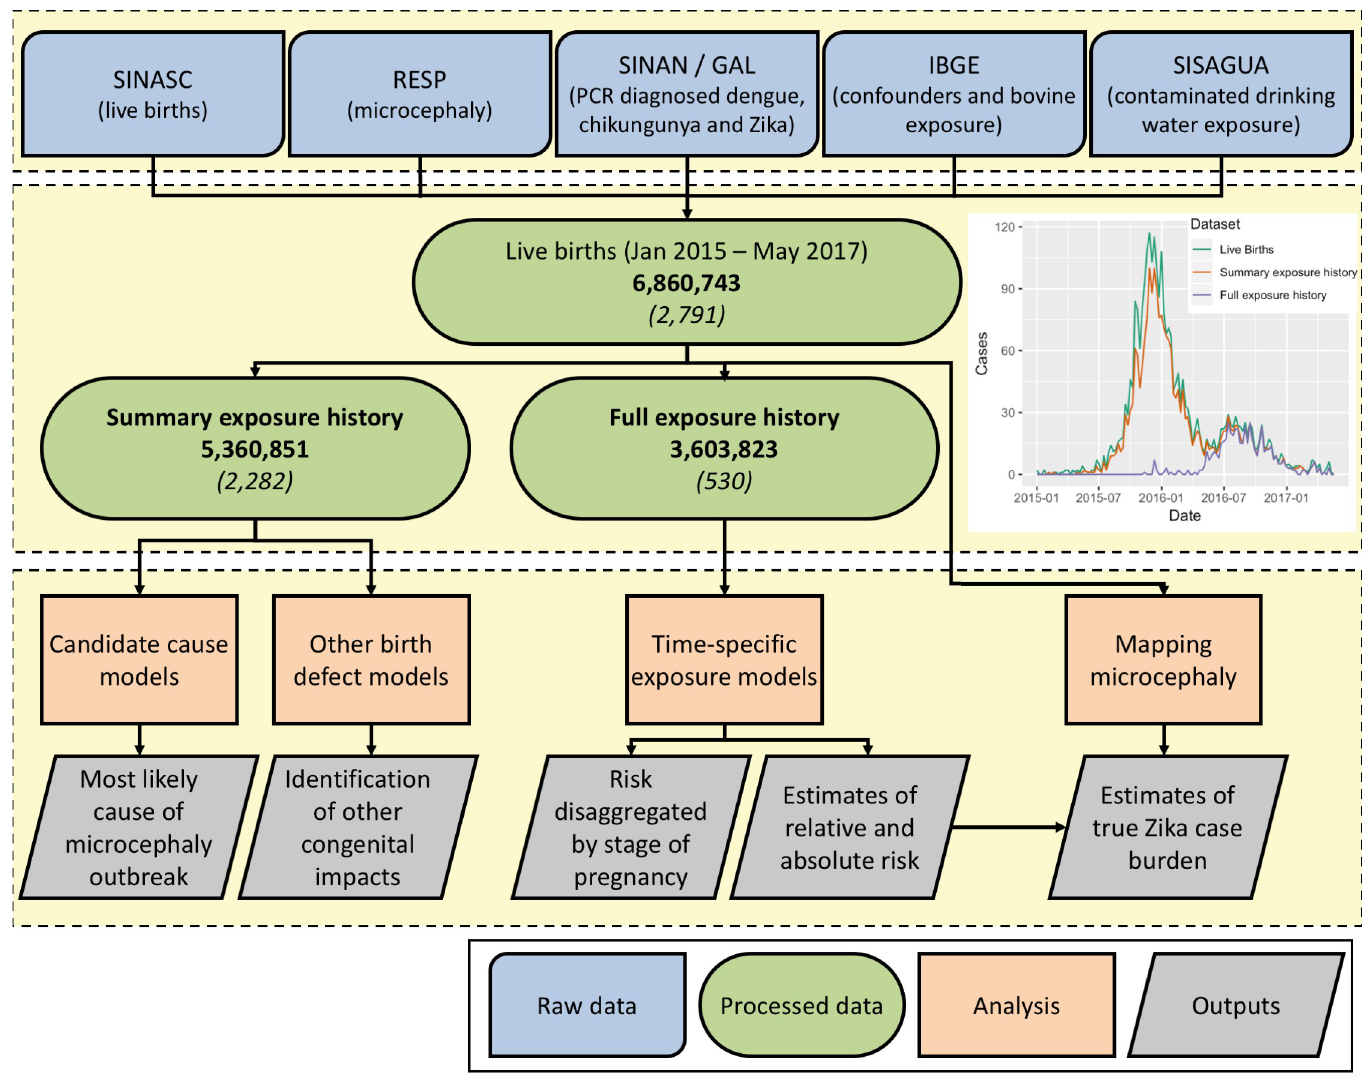
Fig 1. Data sources, data processing, and analysis schema. Numbers in bold indicate total number of births in each category; numbers in italics indicate number of cases of microcephaly with structural brain defects (MWSD) in each category. IBGE, Instituto Brasileiro de Geografia e Estatı´stica; RESP, Registro de Eventos em Sau´de Pu´blica; SINAN/GAL, Sistema de Informac¸ ã o de Agravos de Notificac¸ ã o/Gerenciador de Ambiente Laboratorial; SINASC, Sistema de Informac¸ õ es sobre Nascidos Vivos; SISAGUA, Sistema de Informac¸ ã o de Vigilaˆncia da Qualidade da A´gua para Consumo Humano.